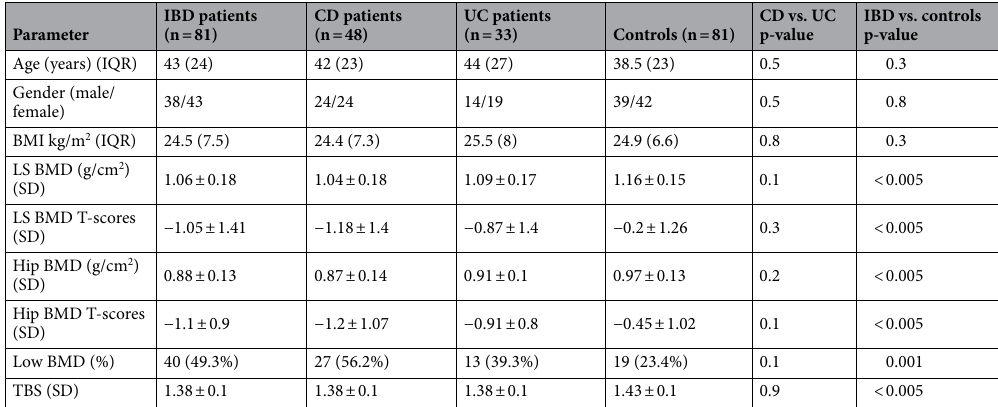
Table 2. DXA parameters and low BMD in case and control group. Values are presented as mean ± SD, percentage. p value presented statistically significant differences p < 0.05. BMI body mass index, LS BMD lumbar spine bone mineral density, BMD bone mineral density, TBS trabecular bone score.